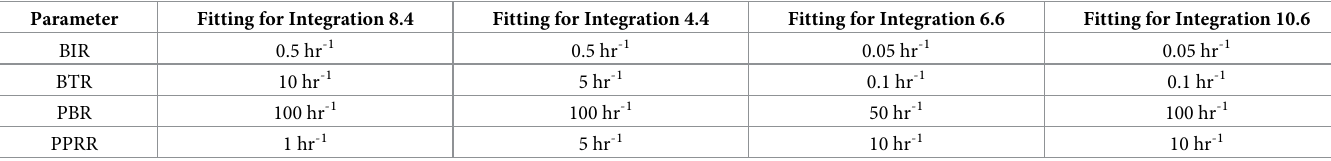
Table 3. Parameters selected for experimental fitting with multi-point activation. Parameter Fitting for Integration 8.4 Fitting for Integration 4.4 Fitting for Integration 6.6 Fitting for Integration